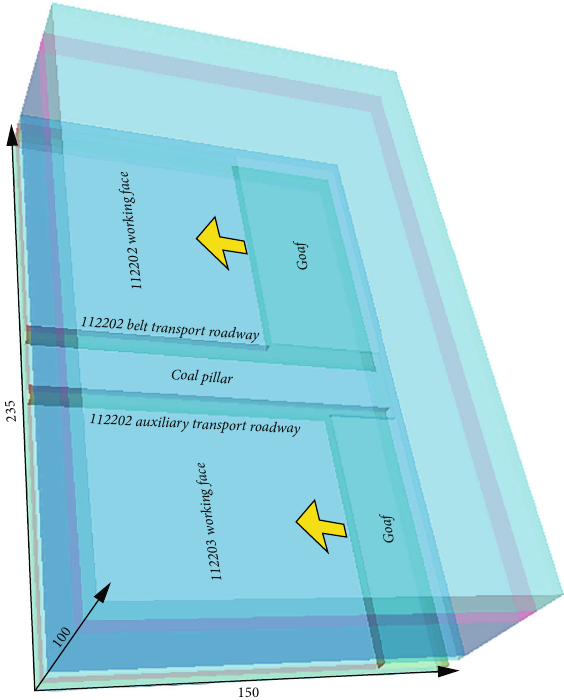
Figure 3: Numerical model.